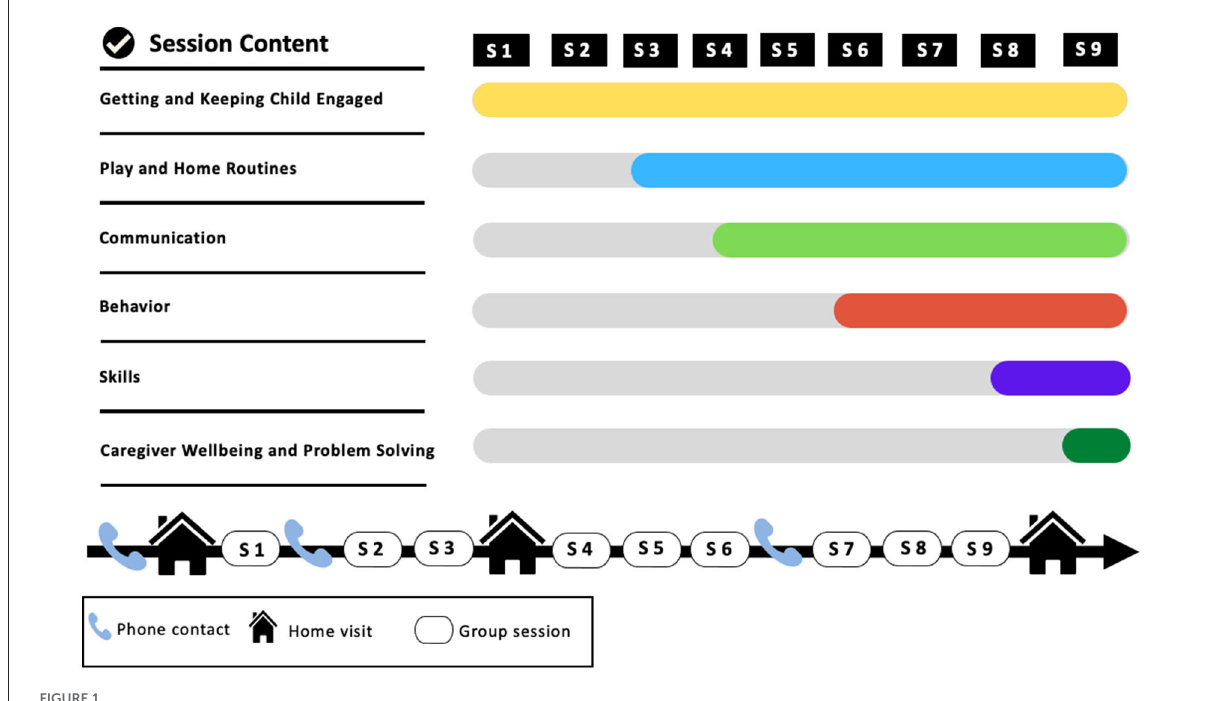
FIGURE1 WHO-CST